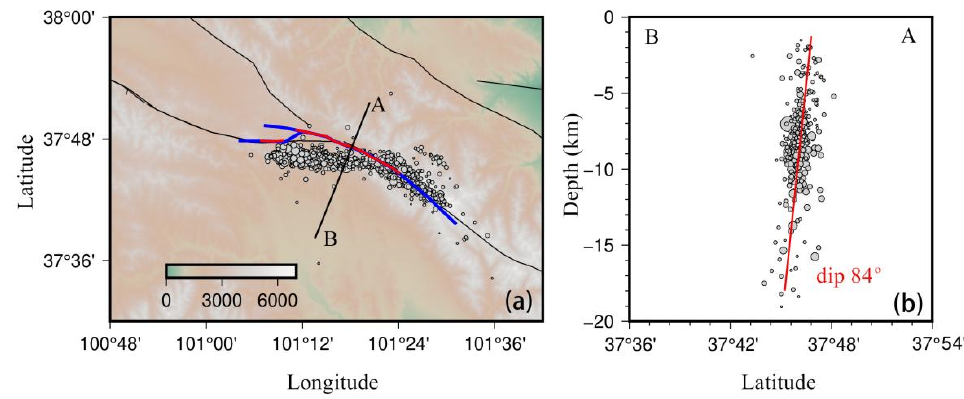
Figure 5. Fault surface trace and relocated aftershocks distribution. ( a ) Optically recognized surface rupture trace (red line), surface trace of fault geometry used in inversion (blue line) and aftershock distributions (gray dots). ( b ) Cross sections of aftershock distributions along profile AB. Courtesy to Hongfeng Yang from the Chinese University of Hong Kong.